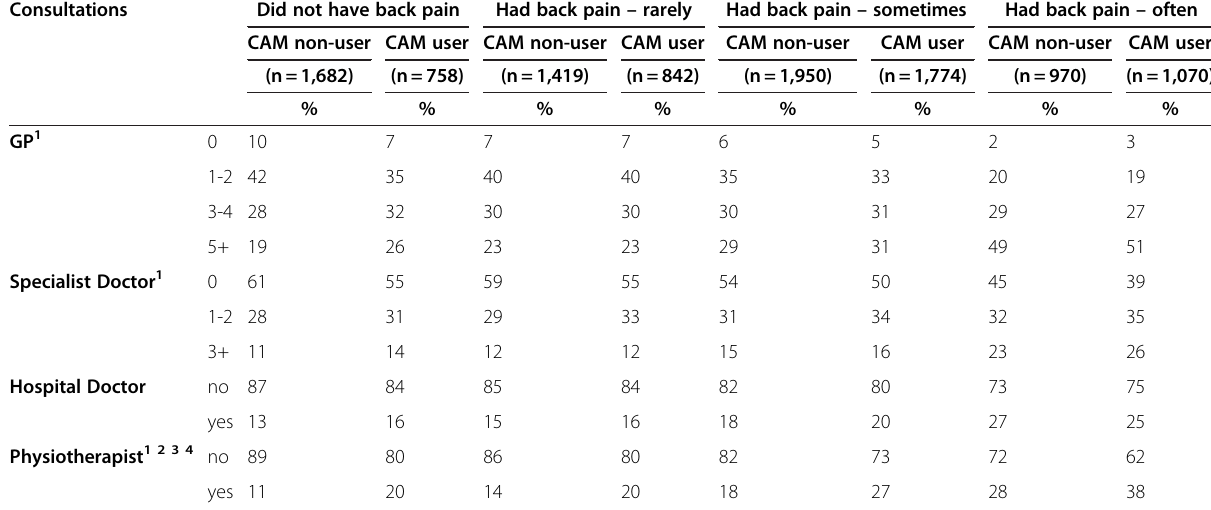
Table 3 Back pain status and consultations with conventional health care providers by CAM user status (consulted with a CAM practitioner or not)